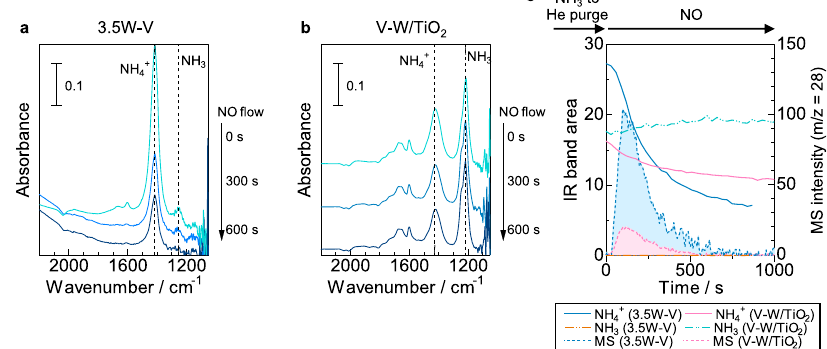
Fig. 10 Difference between bulk and supported catalysts. Operando IR spectra of ad species on a 3.5W – V (bulk W-substituted vanadium oxide) and b V – W/TiO 2 (supported catalyst) during NH 3 adsorption in the presence of water followed by NO exposure at 200 °C. The IR disc was exposed to 0.1% NH 3 /He fl ow in the presence of 2% water vapor (30 min) and purged with He (20 min), followed by exposure to 500 p . pm NO (He balance) fl ow. c IR peak areas of ammonia species adsorbed on Brønsted acid sites (NH 4 + ) and MS intensity of N 2 versus time of NO fl owing. the solution. Next, ammonium metatungstate was added to the solution. Then, the solution was heated overnight to evaporate the water on a hotplate. Finally, the resulting solid was calcined twice at 300 °C for 4h each time. The sample was denoted as x W – V, where x is the molar ratio (mol%) of W to V. The amounts of reagents are shown in Supplementary Table 1. solution was stirred for 10min. For the tungsten precursor aqueous solution, 0.084